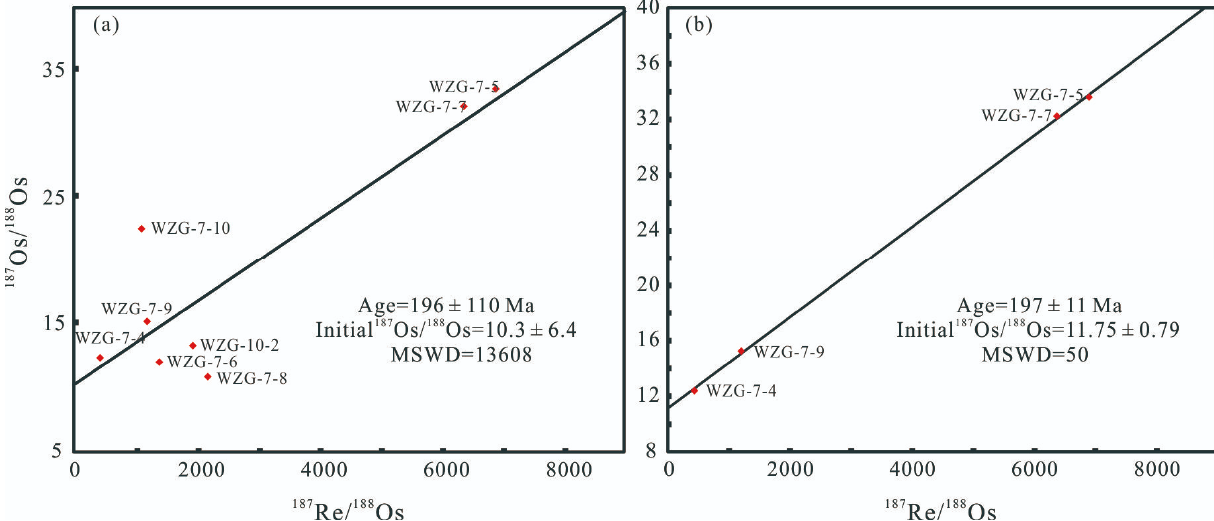
Figure 5. ( a ) Re-Os isochron age diagram of all samples; ( b ) Re-Os isochron age diagram after excluding four samples with large deviations. Table 1. Re-Os compositions of pyrite from the Weizigou deposit. Table 2. LA-ICP-MS results of trace elements (in ppm) of magnetite from the Weizigou